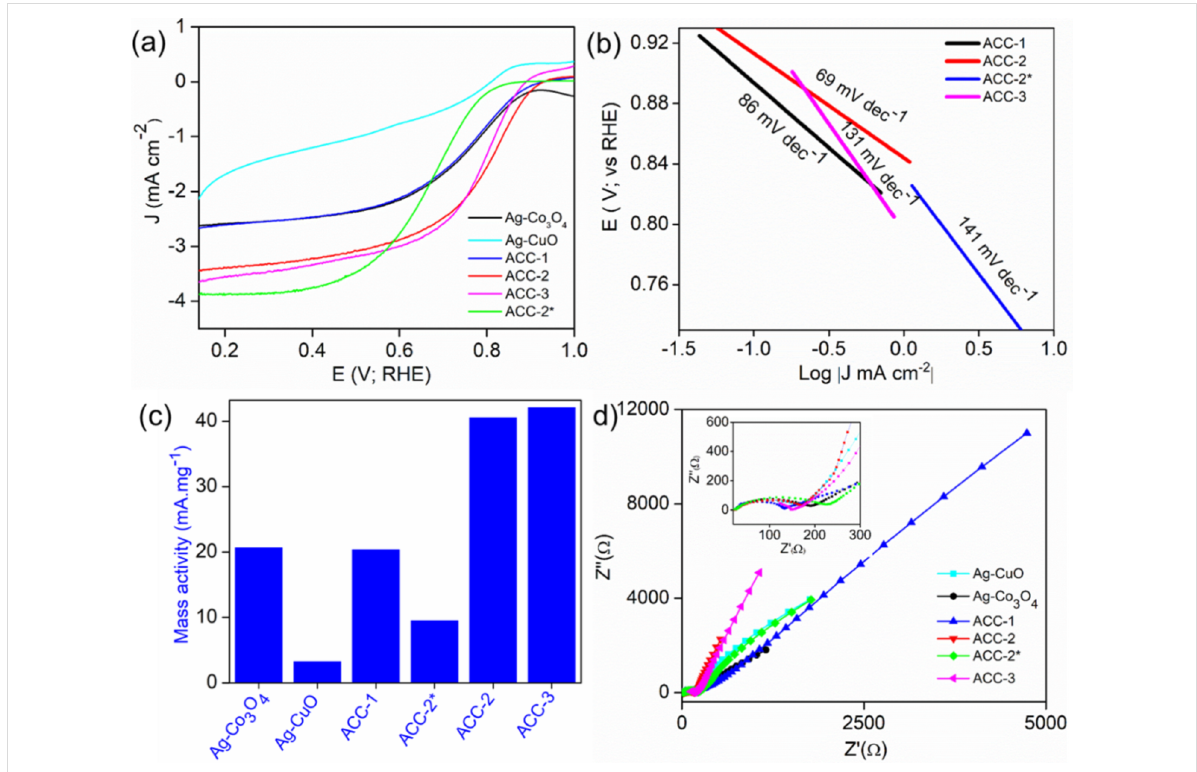
Figure 4: (a) Comparative ORR polarization curves of various catalysts in O 2 -saturated 0.1 M KOH electrolyte at 1600 rpm and a sweep rate of 10 mV·s − 1 . (b) Corresponding Tafel plots. (c) Mass activity obtained at 0.7 V for all active catalysts and (d) Nyquist plots (the inset shows high-fre- quency EIS